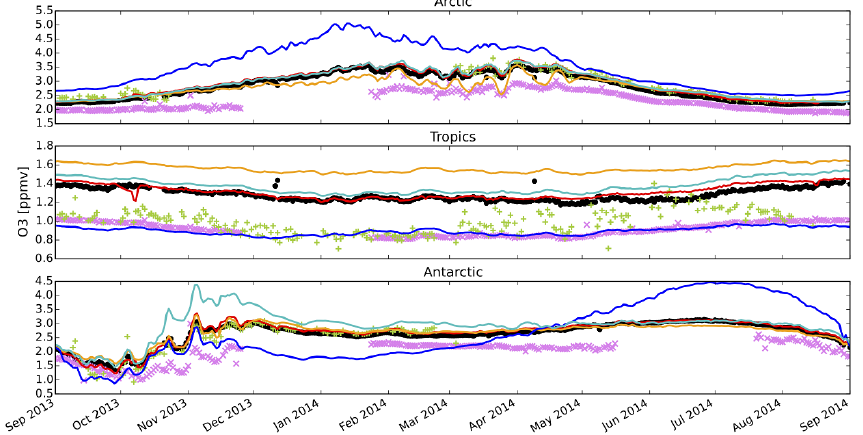
Figure 10. Daily mean time series comparing ozone abundances from the o-suite (red line), the IFS–MOZART coupled system (orange line), C-IFS (CB05) (blue line), and BASCOE (cyan line) with MLS (black dot), OMPS (pink cross) and OSIRIS (green plus) observations for the period 1 September 2013–1 September 2014 at 20km